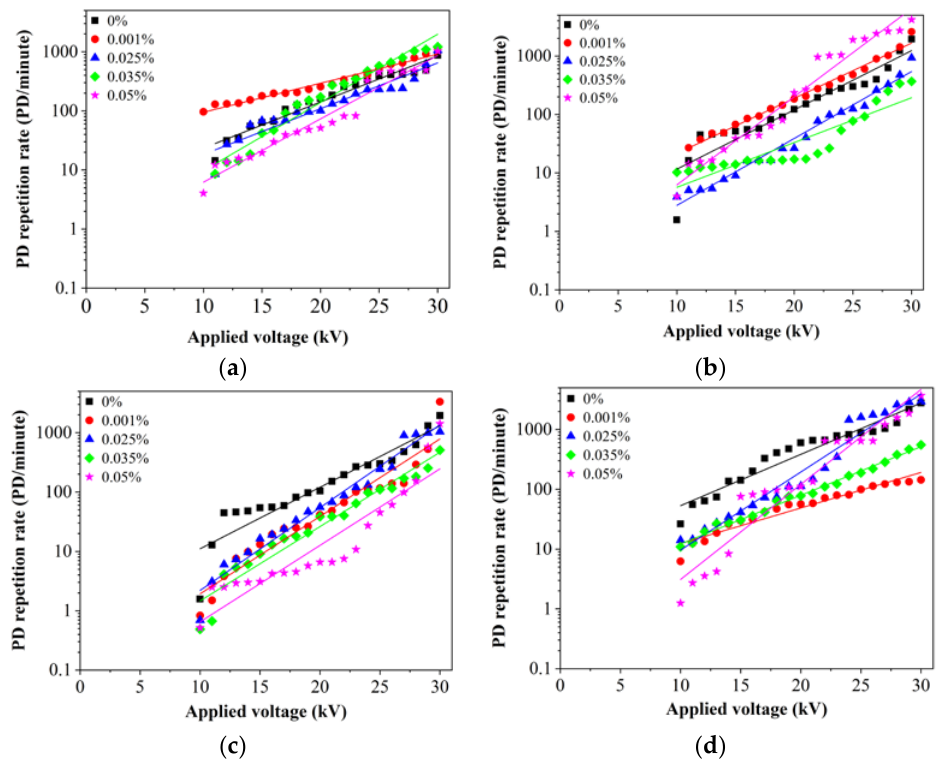
Figure 6. PD repetition rate versus applied voltage for ( a ) RBDPOA, ( b ) RBDPOB, ( c ) CO and ( d ) MO based Al 2 O 3 without